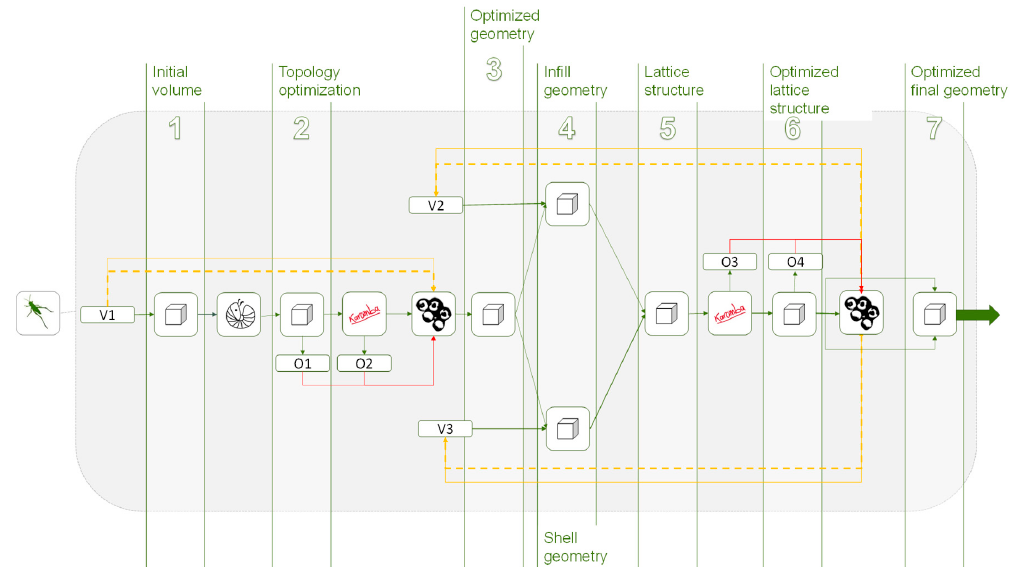
Figure 17. Hierarchical methodology with more than one multi-objective optimization algorithm in which the optimization problem is decomposed into 2; initial volume and lattices structure that includes the infill and the shell.